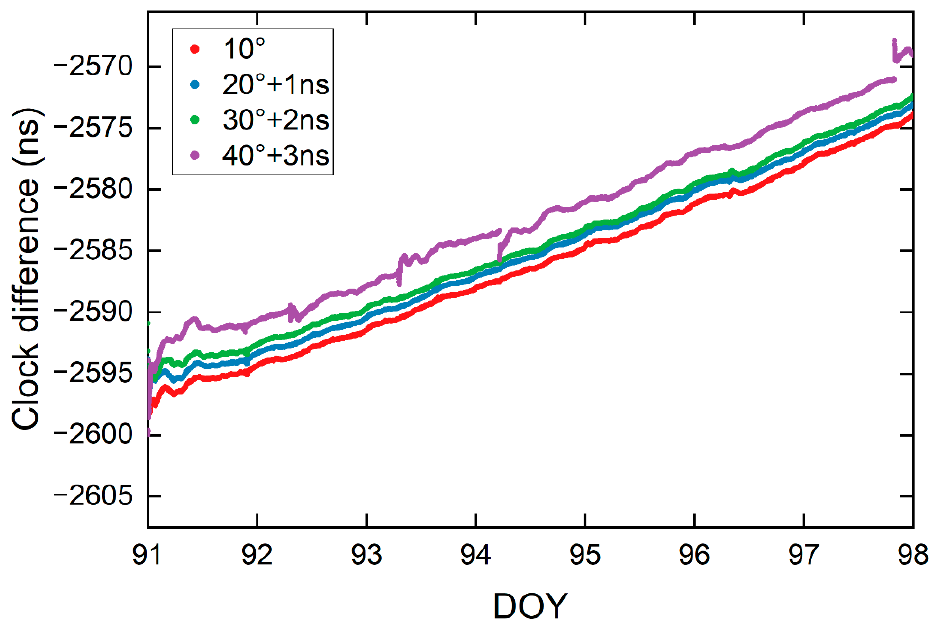
Figure 16. Clock difference of the TLM2-USUD time link. To comprehensively investigate the performance of the B2b-RTPPP time transfer, the STDs of the difference between B2b-RTPPP solutions and GBM-PPP solutions are shown in Figure 18. The B2b-RTPPP time transfer performance decreased as the cut-off elevation angle increased. Moreover, the STD values of the clock difference were within 0.2 ns